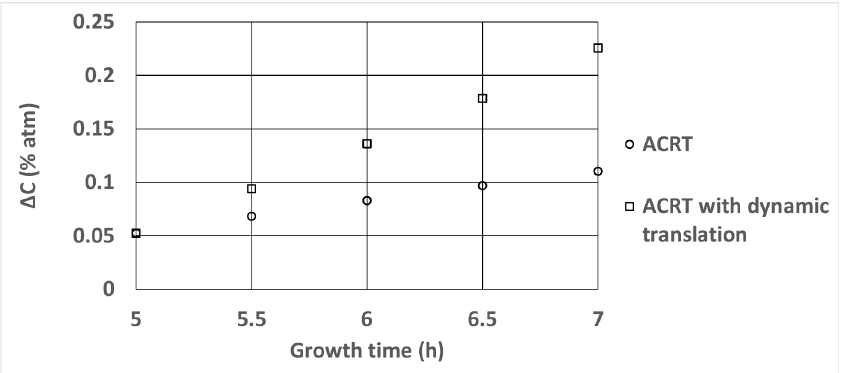
Figure 3. Difference between crystal composition at the wall and at the centerline along the growth interface.